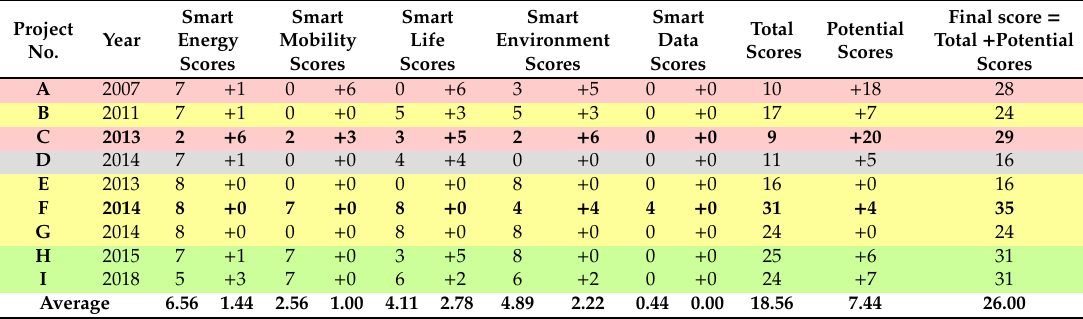
Table 14. Summarized SBICSC assessment